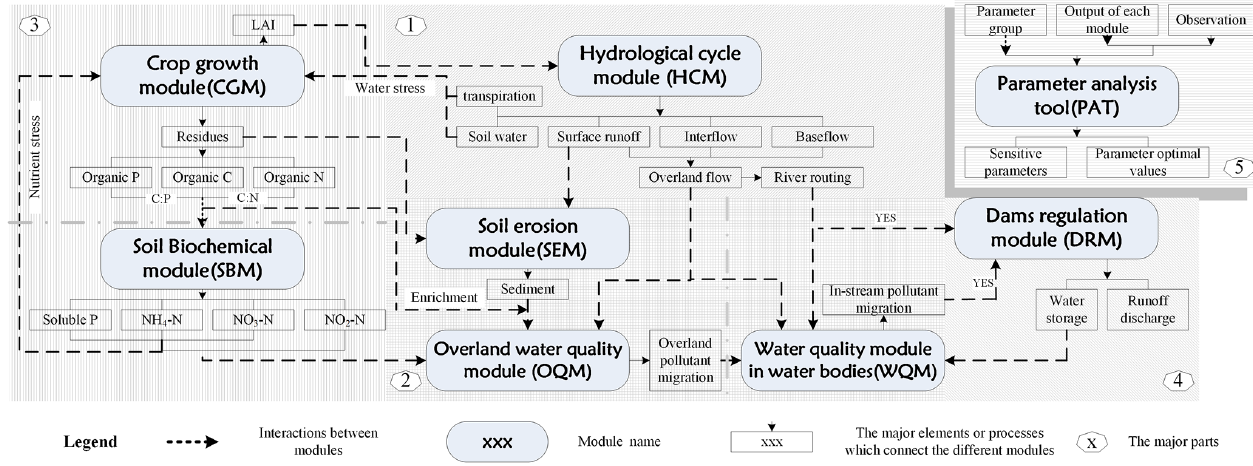
Figure 1. The model structure and the interactions among the major modules (1: hydrological part; 2: water quality part; 3: ecological part; 4: dam regulation part; 5: